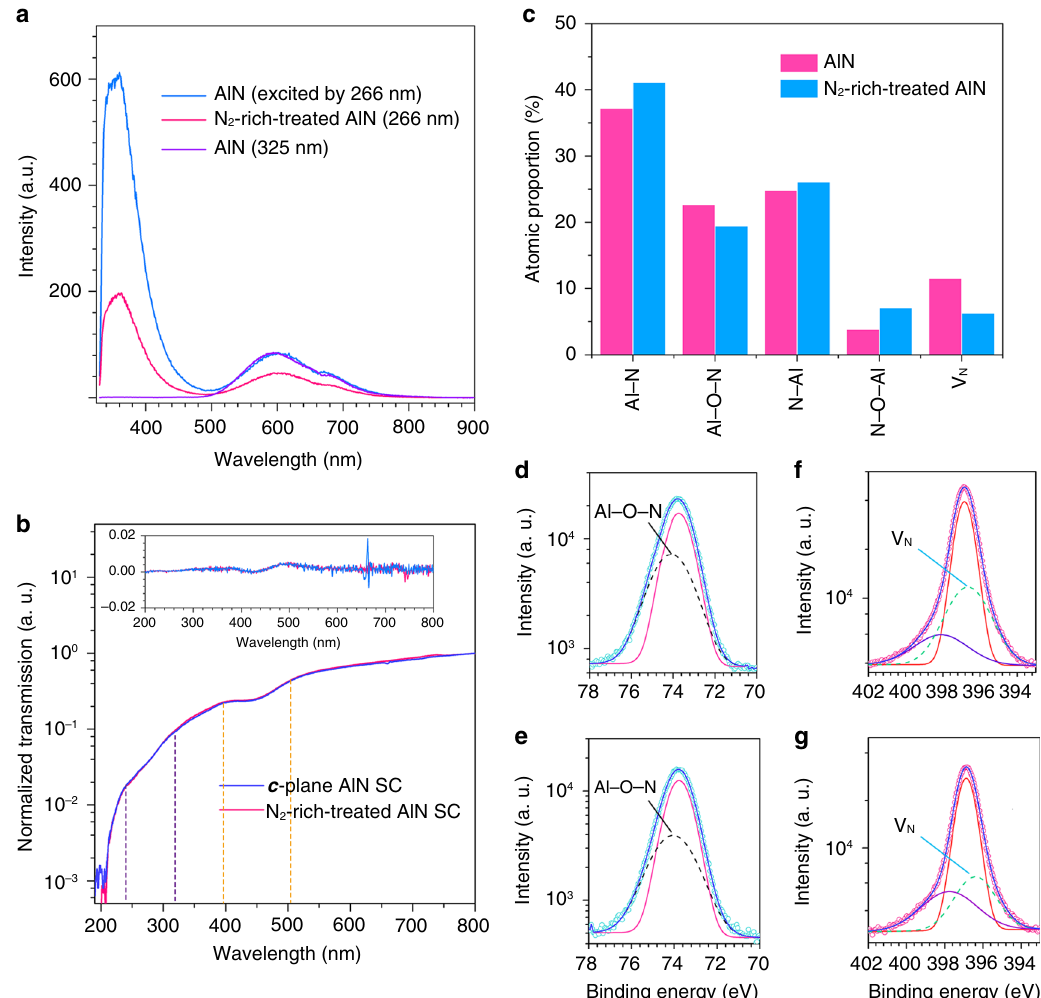
Fig. 4 Analysis of surface defects in AlN SCs with high-temperature N 2 -annealing process. a PL spectra of the AlN SCs under 266 and 325 nm laser excitation. The N 2 -rich-treated AlN shows obviously weaker PL emission than that of as-grown one under 266 nm laser excitation with equal excitation power. b Transmission spectra of the AlN SCs shows no obvious change after high-temperature N 2 -annealing process. The inset is differential transmission (dT). There are two variations of slope in the transmission curve, corresponding to the absorption of V N defects. c Proportion of atomic binds in AlN SC and N 2 -rich treated AlN SC. X-ray photoelectron spectroscopy (XPS) shows the characteristic peaks of Al 2 p electrons ( d , e ) and N 1 s electrons ( f , g